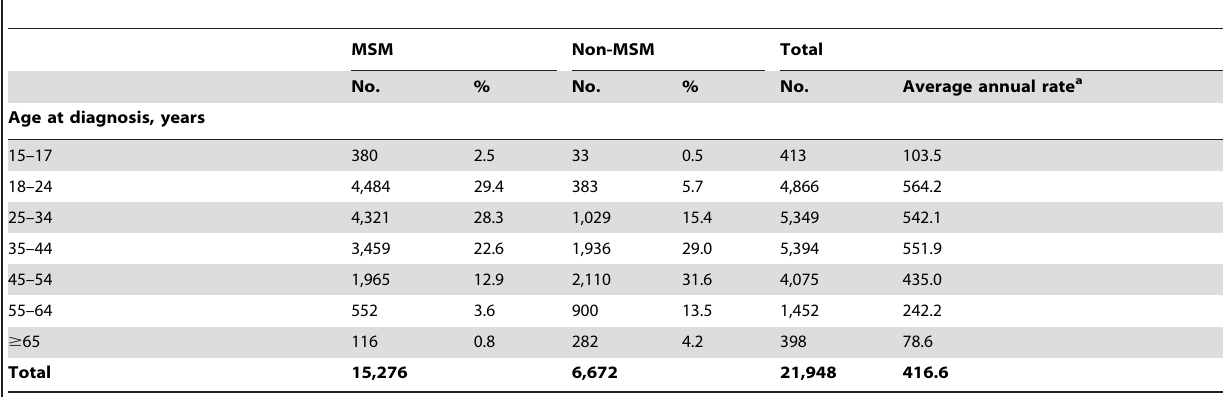
Table 1. Diagnoses of HIV infection among black/African American MSM and non-MSM, by age at diagnosis, 2005–2009—17